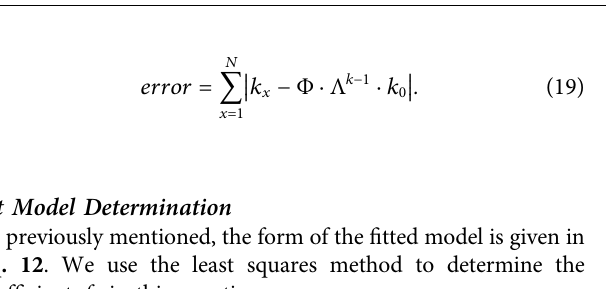
Frontiers in Energy Research |